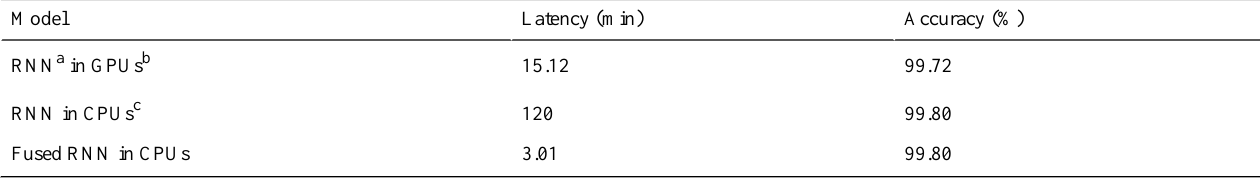
Table 6. Comparison of accuracies and